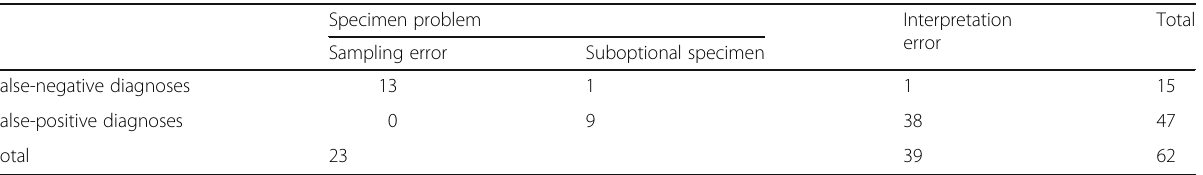
Table 2 The analysis for the misdiagnostic cases